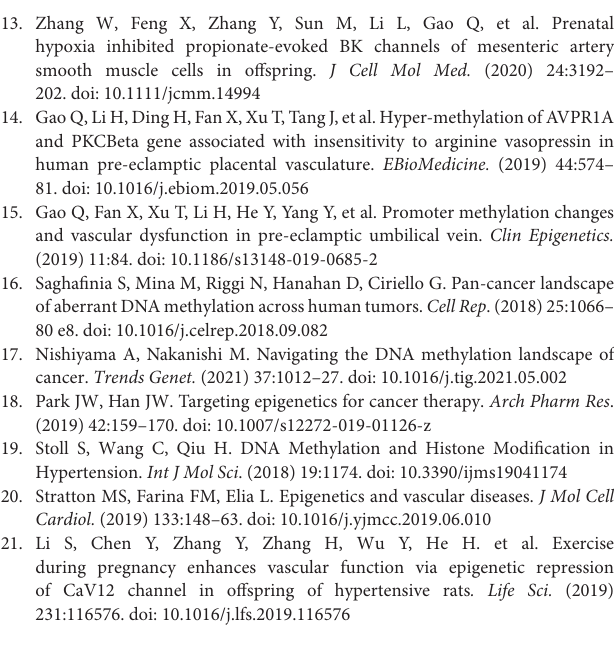
Supplementary Figure 1 | CACNA1C gene expression was calculated after normalization with β -actin (A) or GAPDH (B) . ( A and B ) Quantitative real-time RT-PCR analyses of transcript abundance of CACNA1C expression in TA, MA, MCA, and PA rings after normalization with β -actin (A) or GAPDH (B) (Results of 3 independent experiments). Data are presented as the mean ± SEM of 3 independent